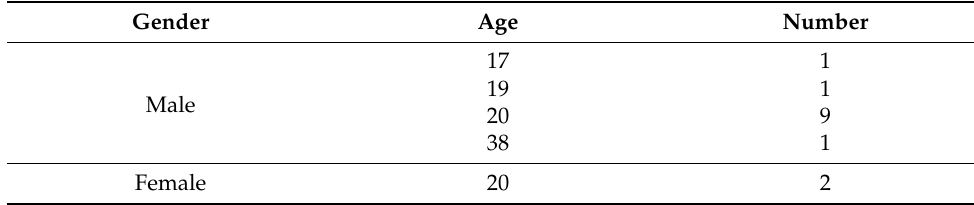
Table 9. Number of subjects and their attributes.